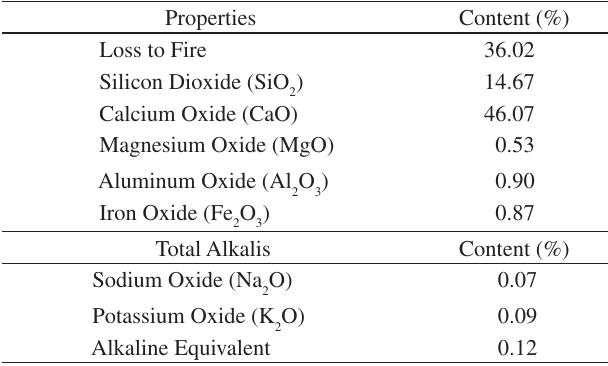
Table 2. Chemical composition of the limestone.